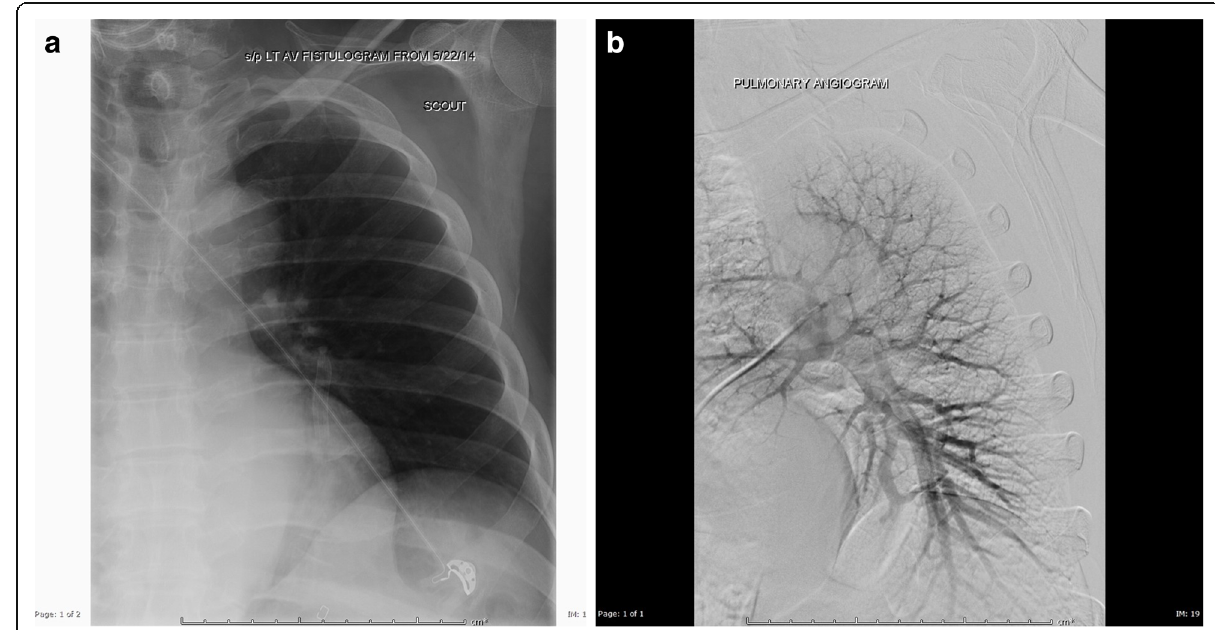
Fig. 4 a: Images on the day the patient was brought in for stent retrieval. b: Pulmonary Angiogram demonstrating the stent in a segmental pulmonary arterial